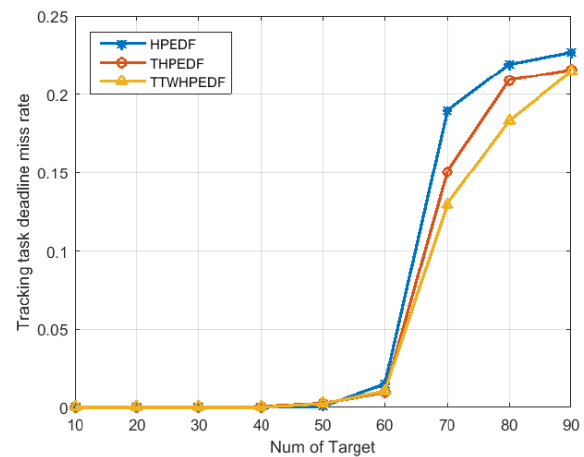
Figure 4. Comparison of missed deadline rates of tracking